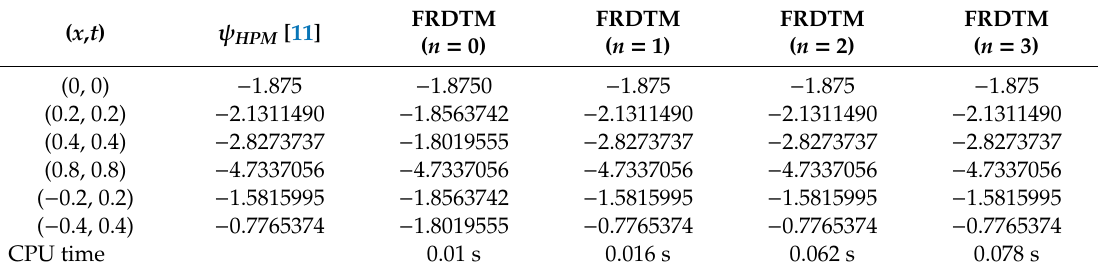
Table 4. The two term FRDTM approximation results of DP equation with HPM [11] for α =